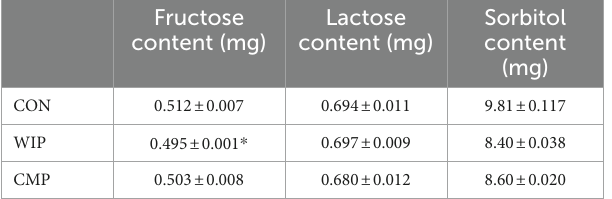
TABLE 2 The contents of FODMAPs after the WIP adsorption